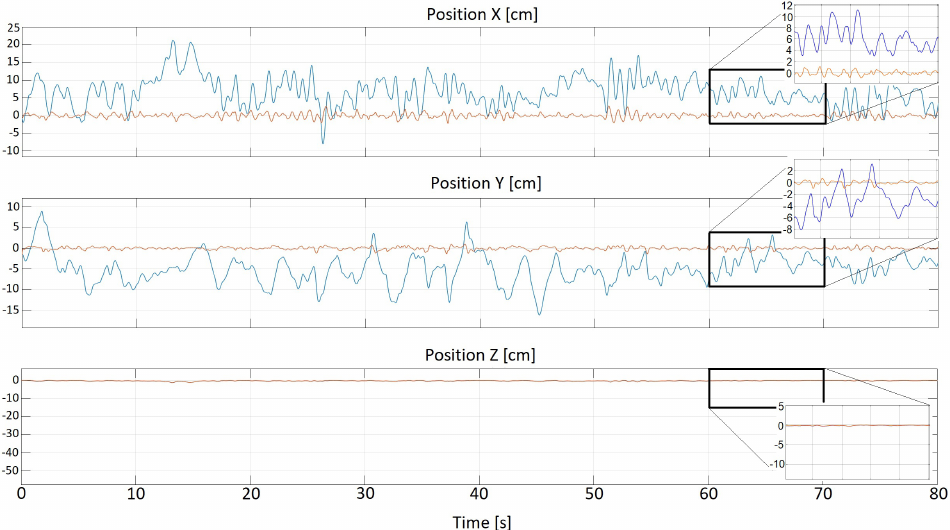
Figure 10. Stabilization studies—the expert method; blue line: disturbances, red line: controlled signal, speed: 10 km/h [Source: MovieBird